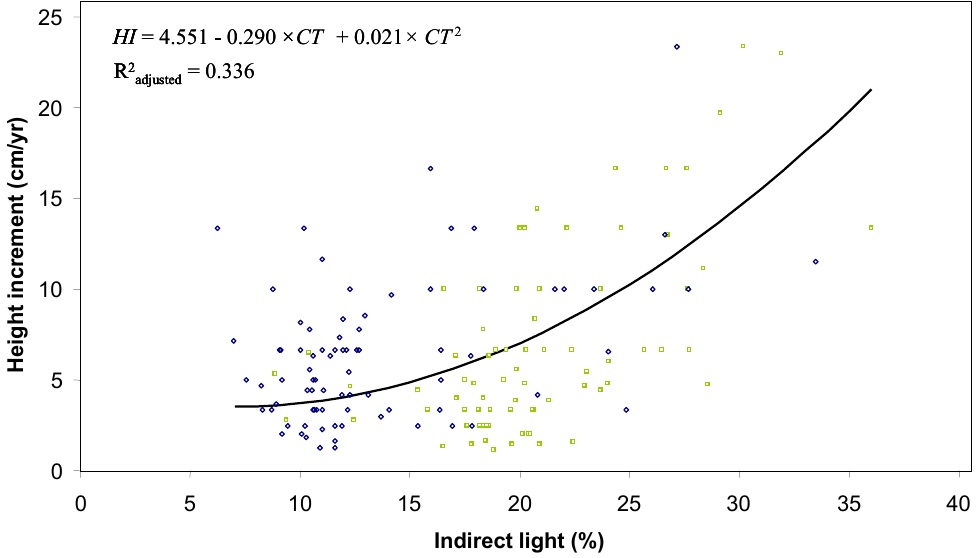
Figure 4. Relationship between age ( T ) and height ( H ) calculated from Equation (1) for northern white-cedar harvested stems of the Outaouais Region (OR site; green squares) and Papineau-Labelle wildlife reserve (PL site; blue diamonds); n = 144 stems.